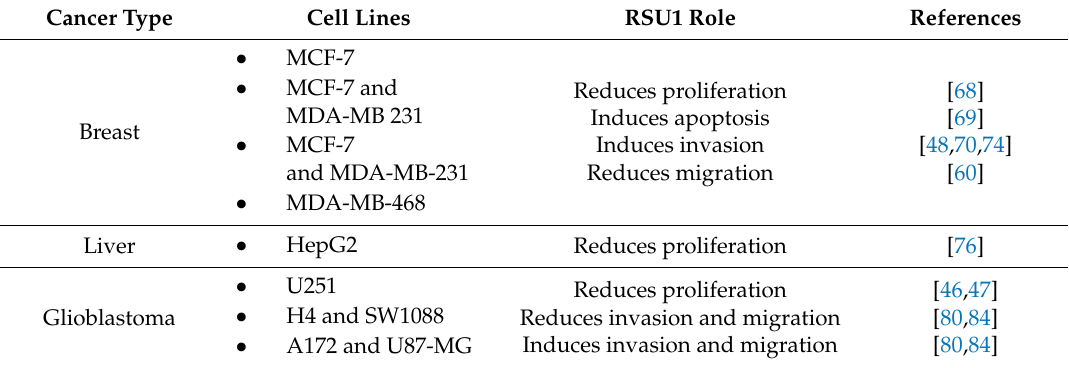
Table 1. Summary of studies on the role of RSU1 in